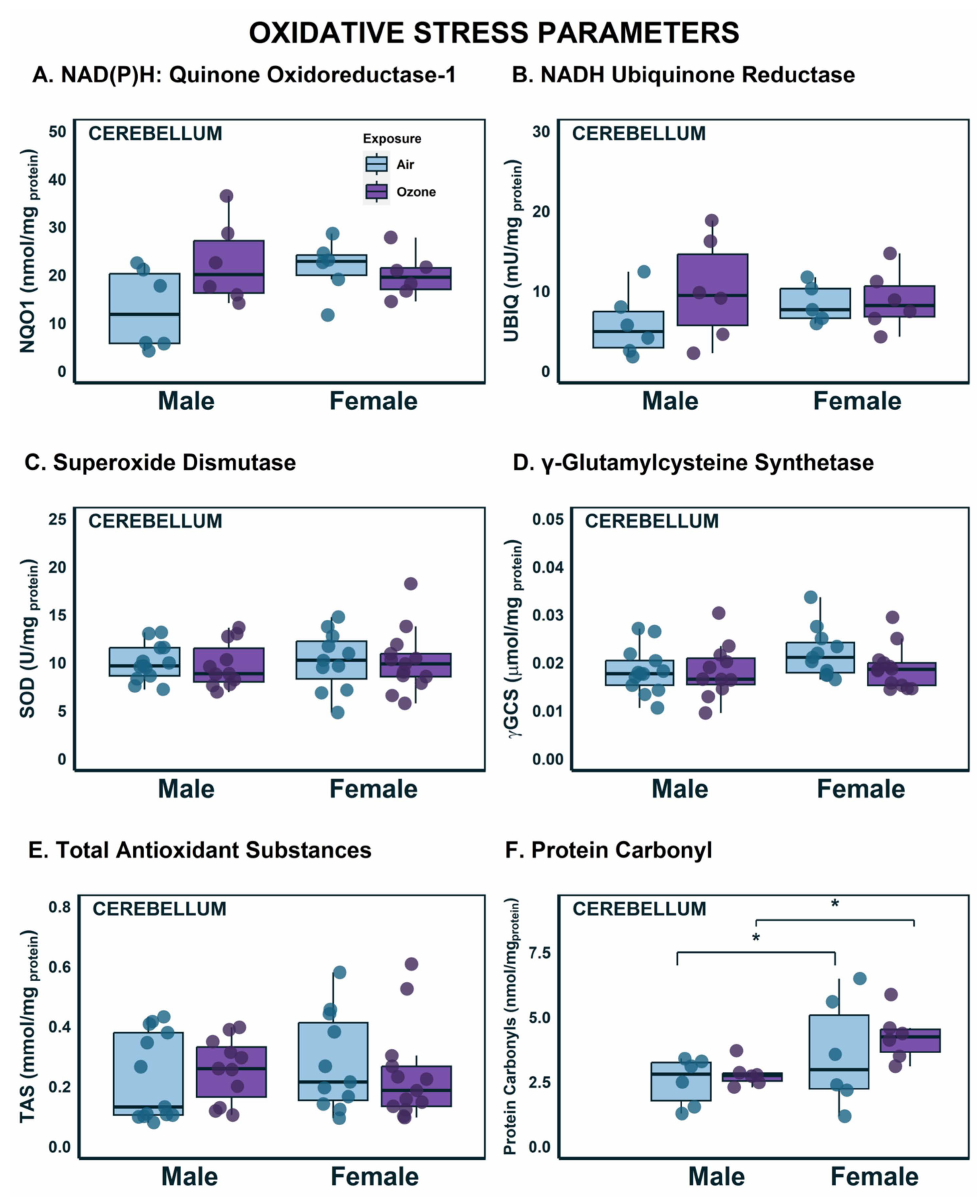
Figure 1. Oxidative stress status in the cerebellum following ozone exposure in male and female rats. ( A ) NAD(P)H Quinone Oxidoreductase-1 activity (n = 6); ( B ) NADH Ubiquinone Reductase activity (n = 6); ( C ) Superoxide dismutase activity (n = 11–12); ( D ) γ -Glutamyl cysteine Synthase activity (n = 11–12); ( E ) Total Antioxidant Substances (n = 11–12); ( F ) Protein Carbonyls (n = 6). * Statistical difference p < 0.05. Data are represented by boxplots with a dot plot overlay to express the distribution of each